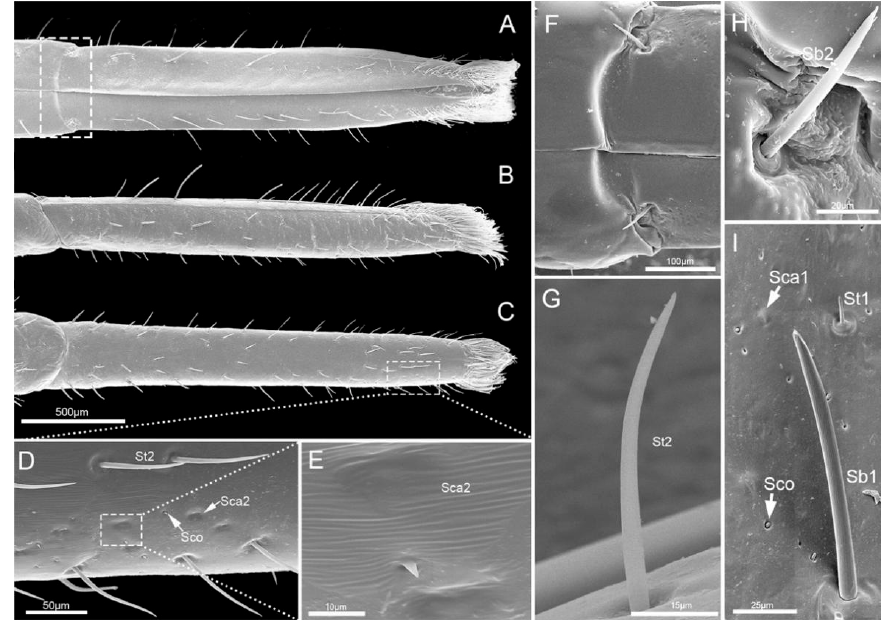
Figure 6 . SEM of the fourth labial segment of E. fullo . ( A ) Ventral view; ( B ) Lateral view; ( C ) Dorsal view; ( D ) Enlarged view of outlined box of ( C ), showing sensilla trichodea 2 (St2), sensilla coeloconica (Sco) and sensilla campaniformia 2 (Sca2); ( E ) Enlarged view of outlined box of ( D ), showing sensilla campaniformia 2 (Sca2); ( F ) Enlarged view of outlined box of (A), showing sensilla basiconica 2 (Sb2); ( G ) Sensillum trichodeum 2 (St2); ( H ) Sensillum basiconicum 2 (Sb2); (I) Enlarged view of surface of the fourth segment, showing sensilla campaniformia 1 (Sca1), sensilla trichodea 1 (St1), sensilla coeloconica (Sco) and sensillum basiconicum 1 (Sb1).